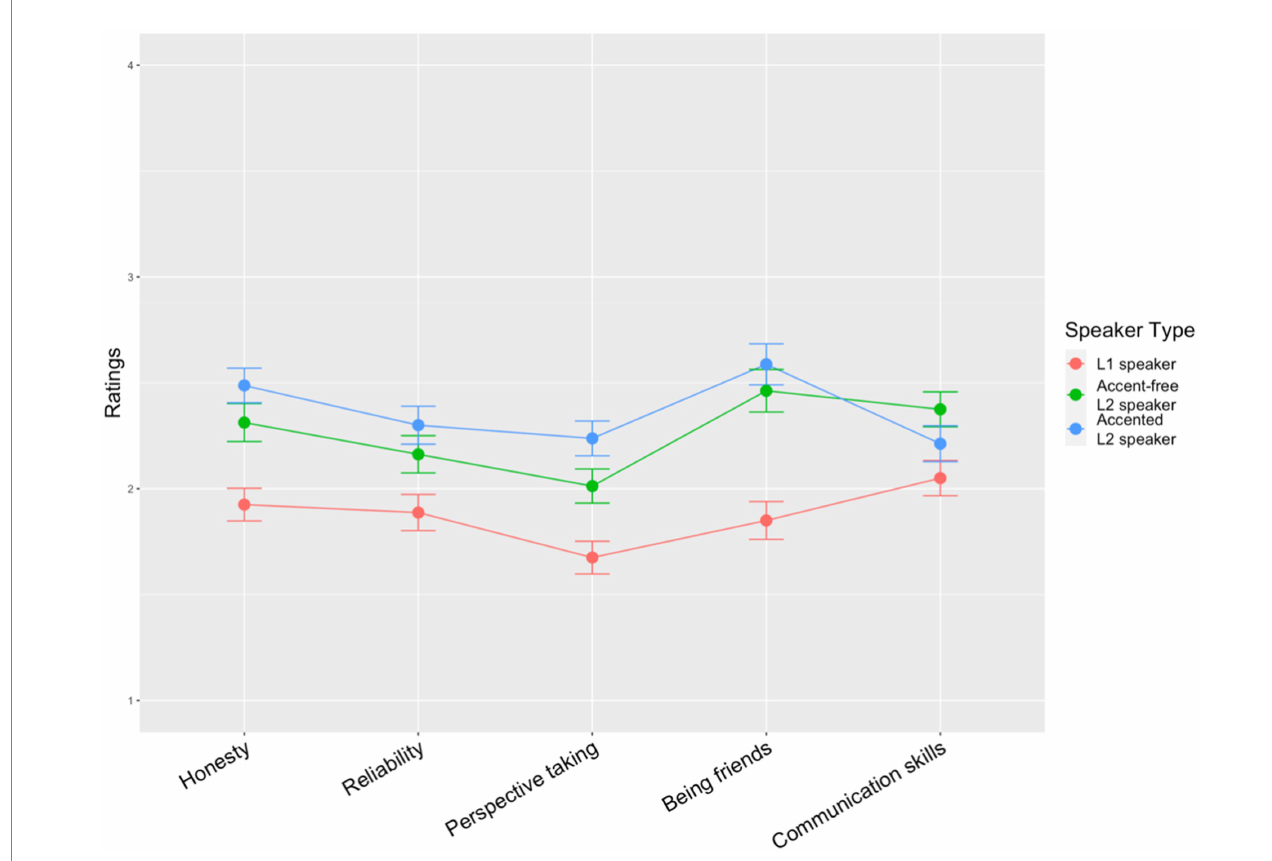
FIGURE 5 Mean ratings of the five attributes with points and standard error bars (the y -axis represents the degree of each attribute, e.g., the higher the ratings of honesty are, the more honest the participants think the speaker